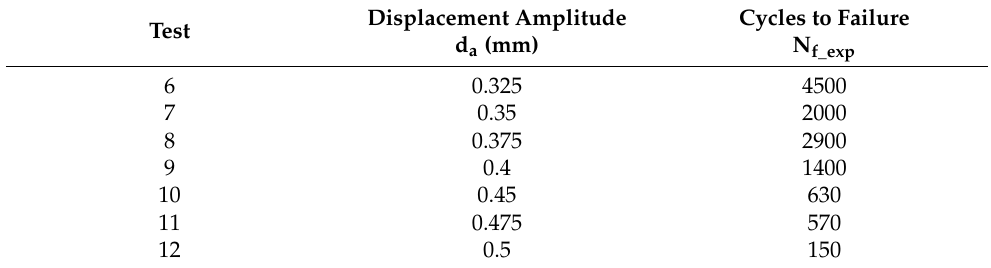
Table 6. LCF tests at R d = − 1.